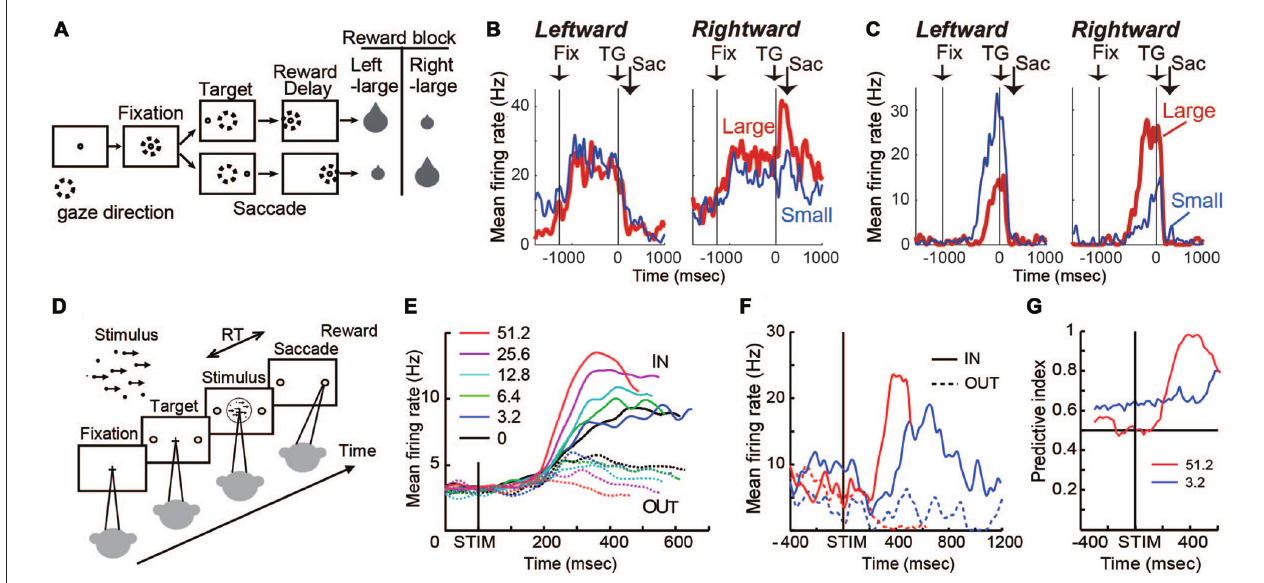
FIGURE 1 | (A) Visually guided saccade task with an asymmetric reward schedule. After fixating on the central fixation point (FP), a target cue appeared immediately on either the left or right, to which the monkey made a saccade to receive a liquid reward. The dotted circles indicate the direction of gaze. In a block of 20–28 trials (e.g., left-large block), one target position (e.g., left) was associated with a large reward, and the other position (e.g., right) was associated with a small reward. The position-reward contingency was then reversed (e.g., right-large block). (B) An example dorsal caudate neuron showing a target-direction effect (right-target dominant) after target onset until reward delivery. This neuron also showed a reward-size effect (right-large-reward dominant). Spike density functions (top) and raster plots in the chronological order are aligned to target onset (left, TG on) and reward onset (right, RW on). Red: large-reward trials; blue: small-reward trials; green dots: FP onset; black dots: saccade onset; light blue dots: reward onset and offset. Dots for reward offset are only visible for large-reward trials. (C) An example dorsal caudate neuron showing a reward-direction effect. Note that this neuron showed stronger pre-target activity for the right-large block. (D) The motion discrimination task. The monkey decides the global motion direction of a random-dot kinematogram and then at a self-determined time, make a saccade to one of two choice targets. Saccades to the target in the direction of coherent motion are followed by juice reward. (E) Population average of evidence accumulation activity aligned on stimulus onset for correct trials (truncated at median reaction time (RT) after excluding activity 100 ms before saccade onset). Solid lines, trials to the neurons’ preferred direction (IN trials); dashed lines, trials away from preferred direction (OUT trials). Coherence levels are indicated by colors. (F) Activity of an example neuron before and during motion viewing. Blue, 3.2%; red, 51.2% motion coherence. Note that the activity before stimulus onset was different between trials with different final choices (solid vs. dashed lines) at 3.2% coherence, but it was not at 51.2% coherence. (G) Time course of the predictive index, which quantifies how well an ideal observer can predict the final choice based on neural activity. Before stimulus onset, it was significantly larger than chance (0.5) for low motion-strength trials (e.g., 3.2% coherence) and at chance for high motion-strength trials (e.g., 51.2% coherence); after stimulus onset, the pattern reversed, with the predictive index increasing sharply for high motion-strength